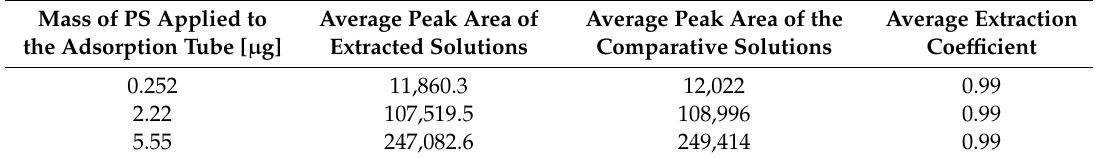
Table 3. Tests of PS extraction degree from silica gel and filter. GC ‐ MS, HP ‐ 5MS column, programmable column temperature.